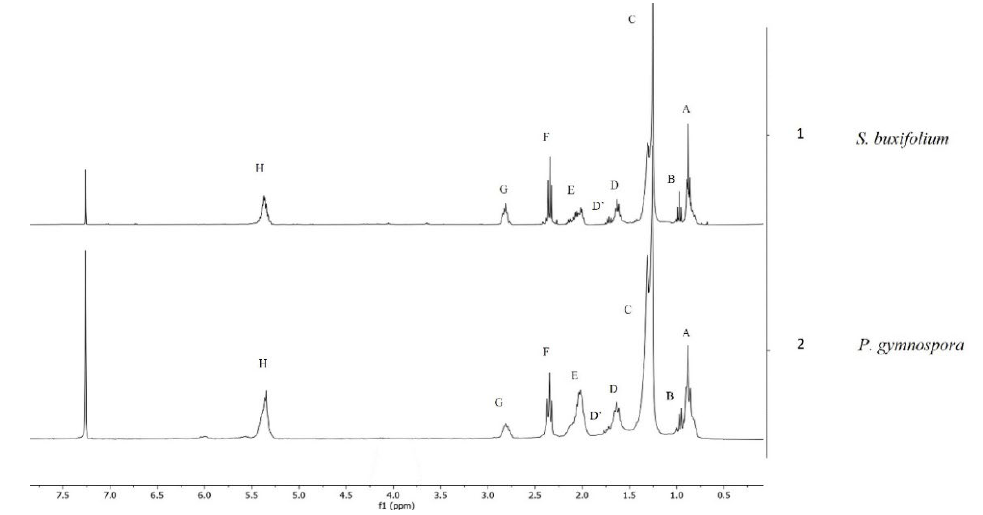
Figure 1. 1 H-NMR spectra of S. buxifolium and P. gymnospora hexanic extracts